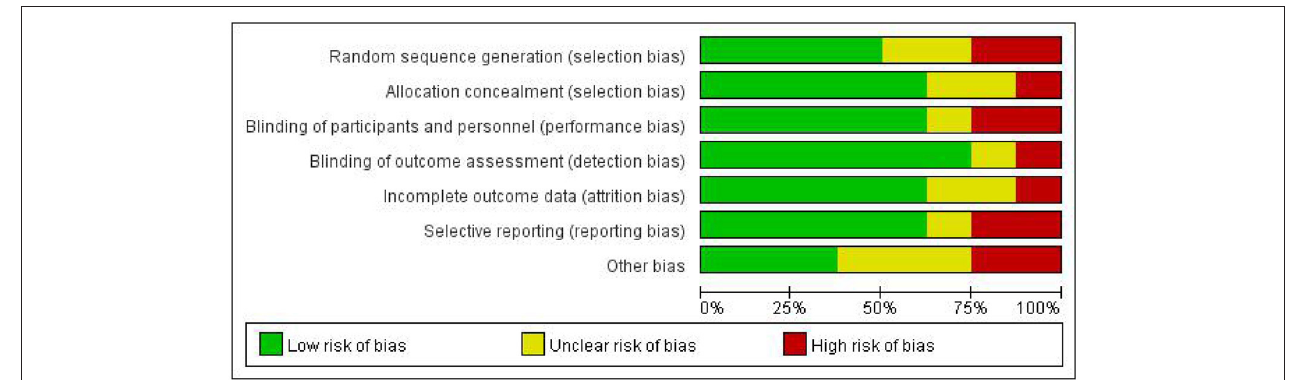
Frontiers in Surgery |